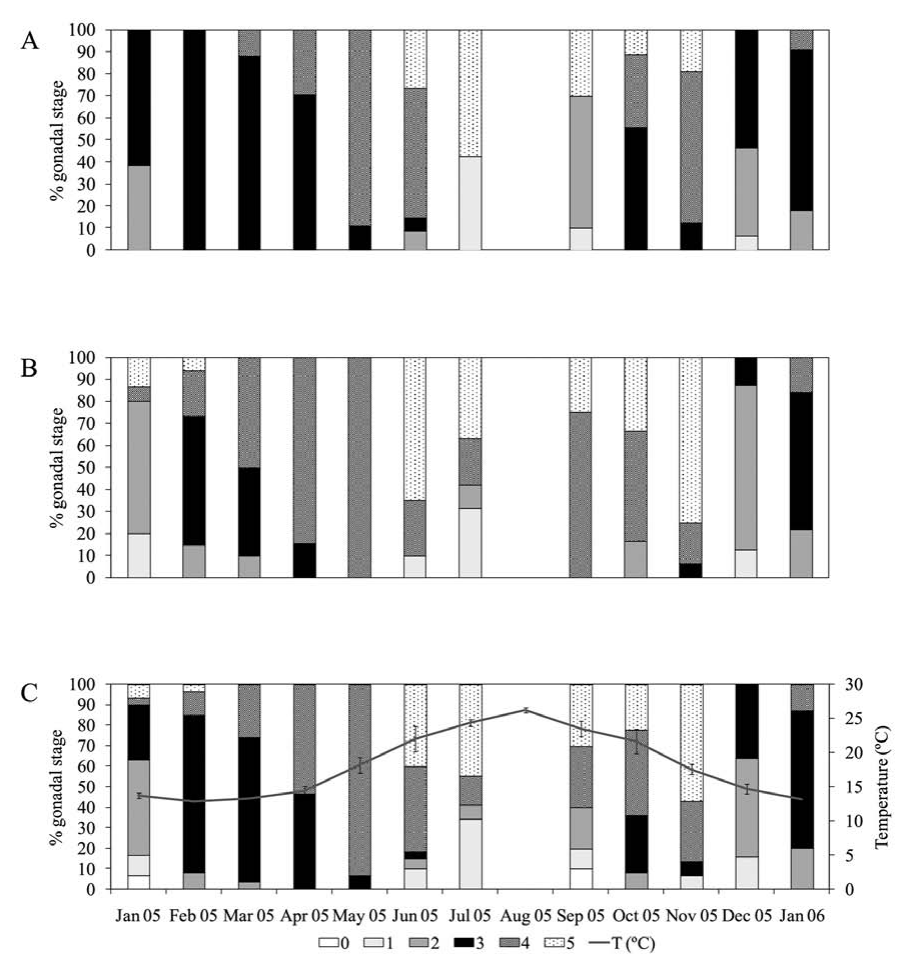
Fig. 1. – Monthly average temperature and relative frequency of the different gonad development stages throughout the period of study for males (A), females (B), and the whole population (C). Stage 0, inactive; Stage 1, early active; Stage 2, late active; Stage 3, ripe; Stage 4, spawning period; Stage 5,